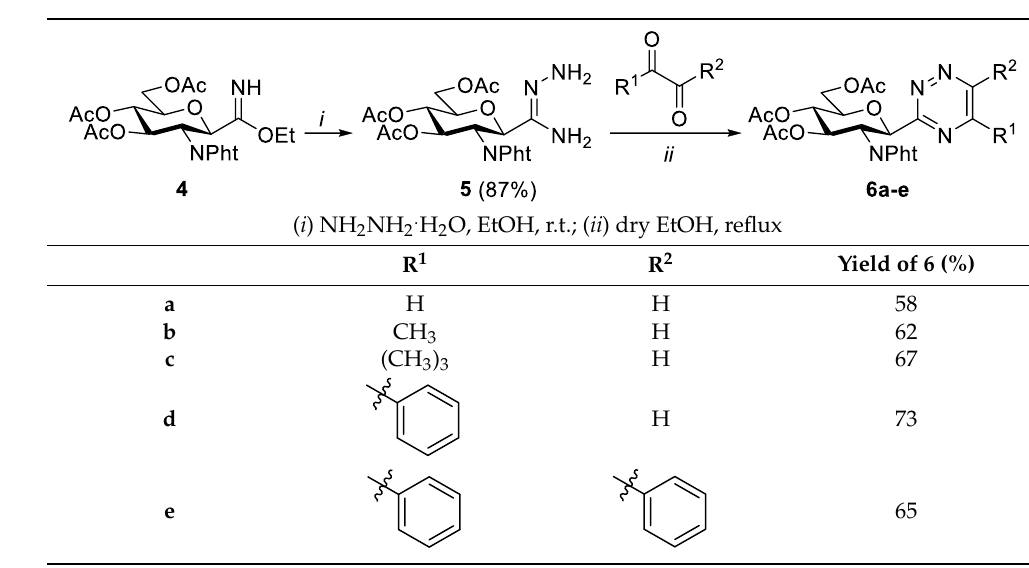
Table 2. Synthesis of 3-( 2′ -deoxy- 2′ -phthalimido- 3′ , 4′ , 6′ -tri- O -acetyl- β - D -glucopyranosyl)-1,2,4-triazines.